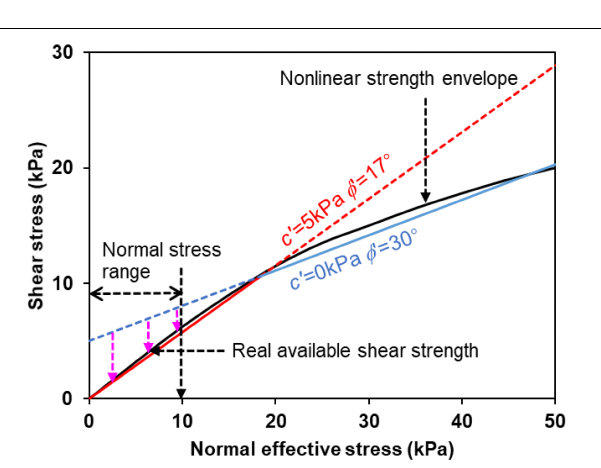
FIGURE 14 | Illustration of the non-linear behavior of mobilized shear strength at low confining stress level.